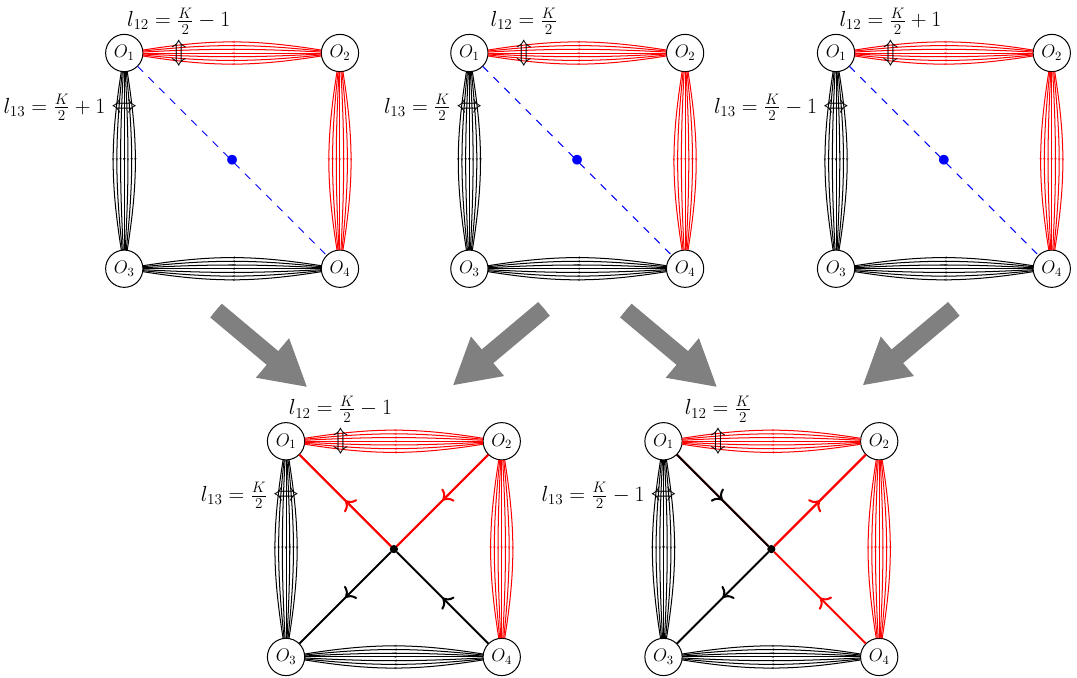
Figure 7 . At the top the skeleton graphs that we need to hexagonalize and add up to obtain the one-loop simplest four-point function. At the bottom an interpretation of the neighboring graphs in terms of Feynman